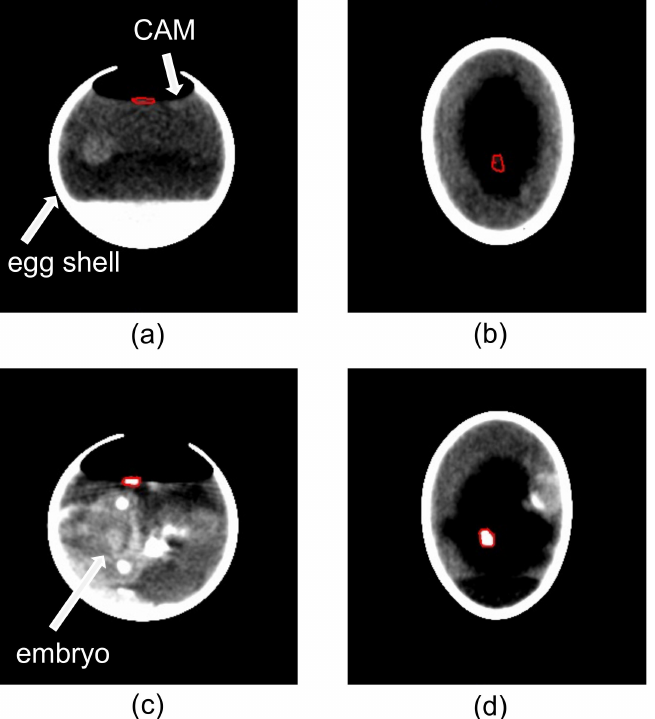
Figure 10. CT-based volume measurement of a cystic tissue depicted in the cyst window ( n = 36). The cystic tissue is marked by the red border in each image. The chicken egg with engrafted cystic tissue is shown one day after engraftment in the transverse ( a ) and coronal ( b ) planes without any signs of calcifications. A significant increase in hyperdense structures in the cystic tissue was visible in the transverse ( c ) and coronal ( d ) planes of the second measurement, which took place hours before removal of the cystic